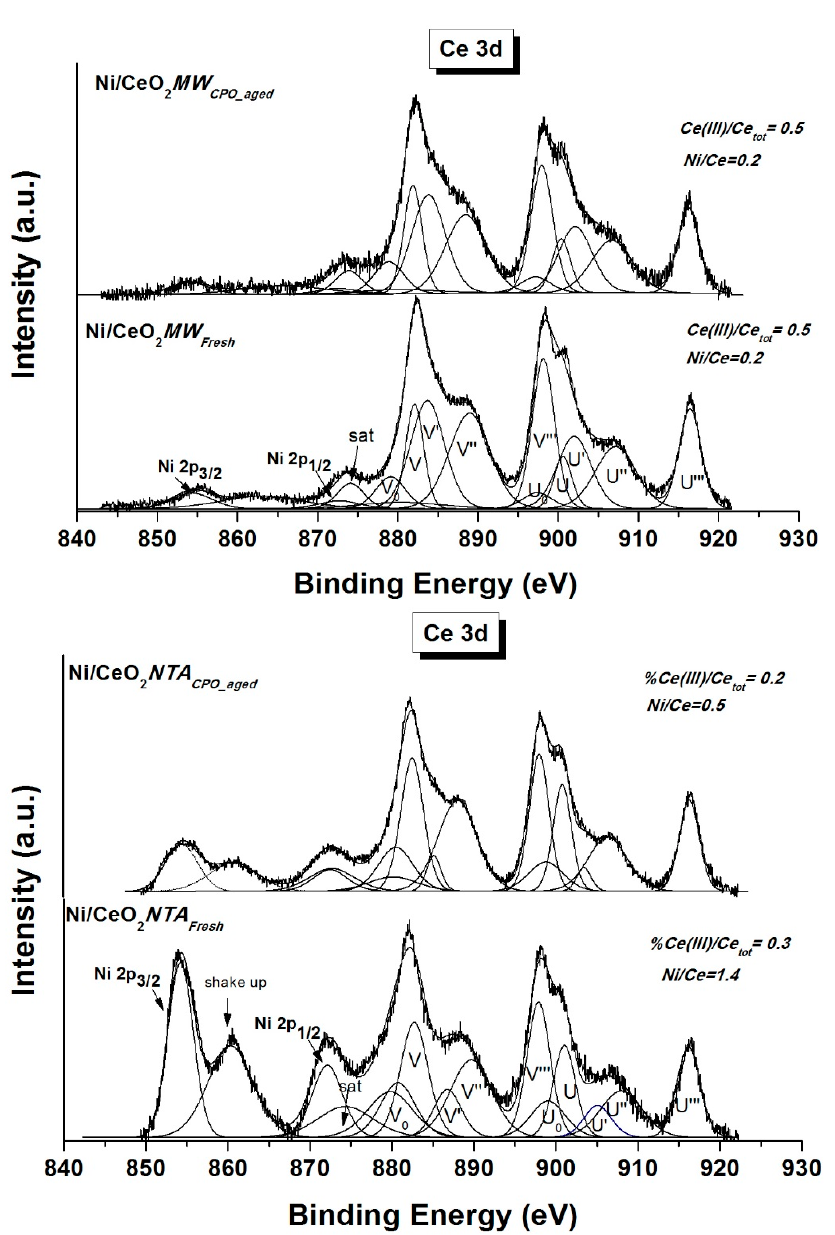
Figure 6. Ni 2p and Ce 3d photoelectron spectra of the catalysts as fresh and after the catalytic partial oxidation (CPO) test.